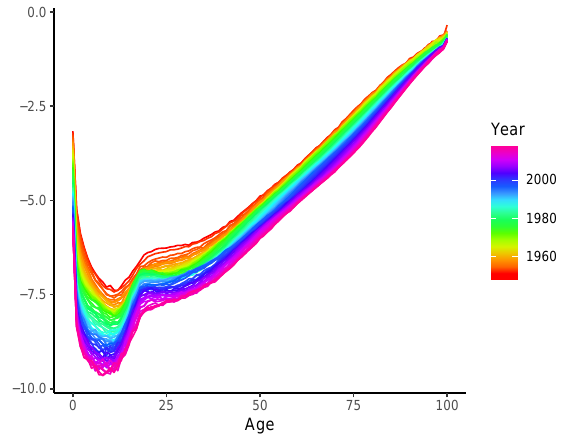
Figure 1. Averaged logged mortality